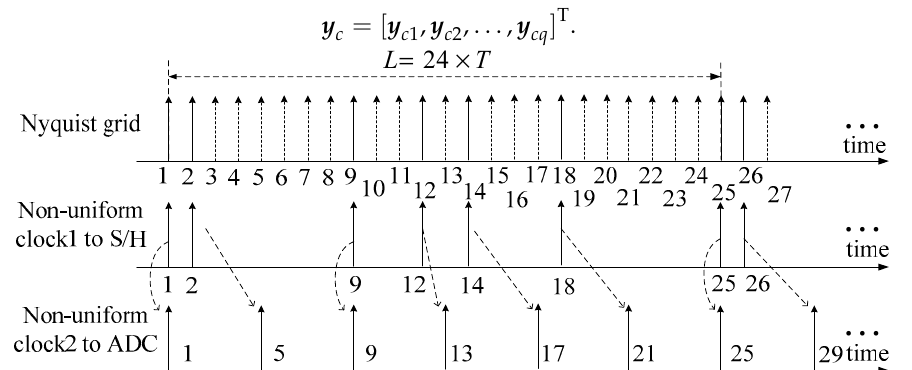
Figure 3. The sampling process of serial MCS.